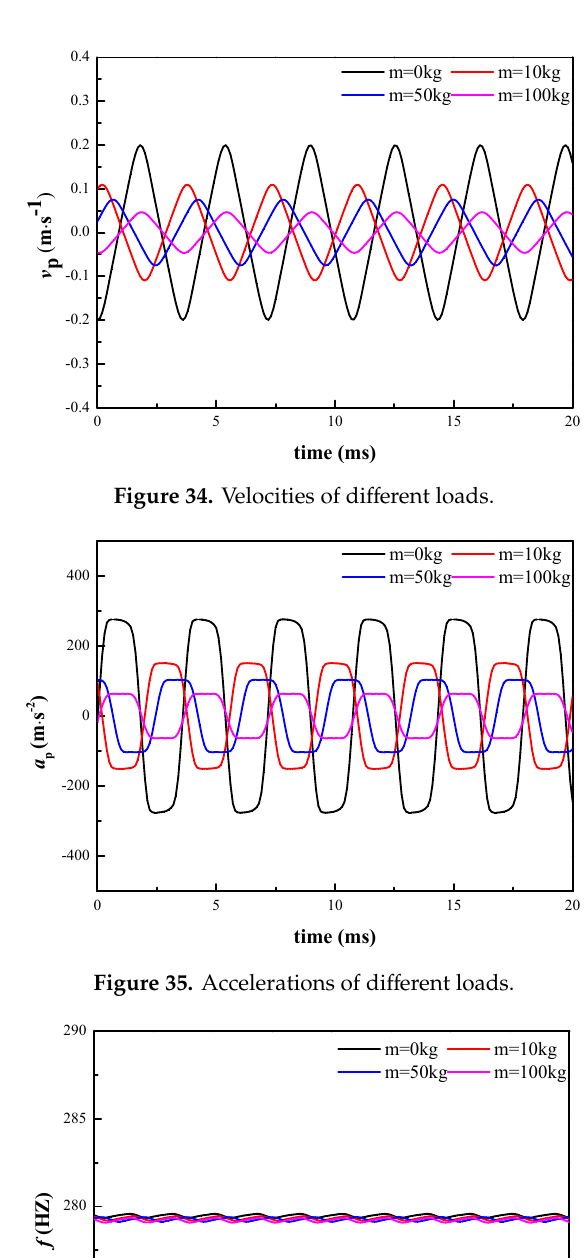
Figure 33. Displacements of different loads.